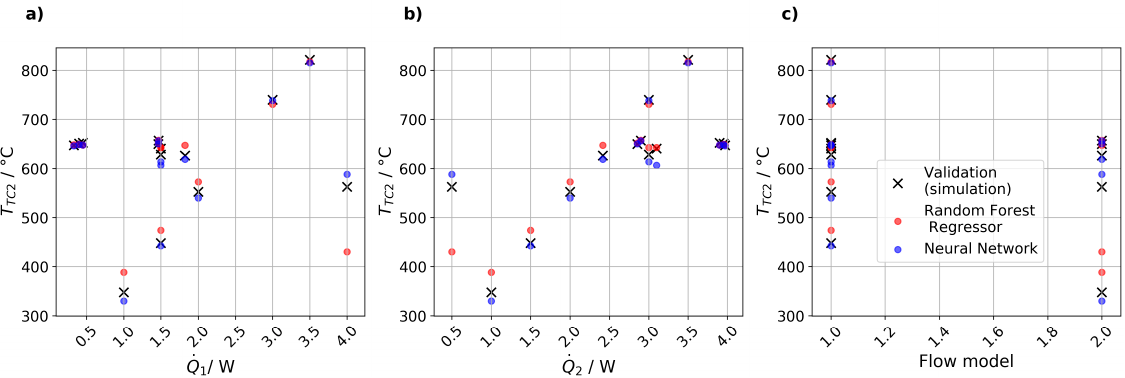
Figure 6. Exemplarily comparison of prediction data from random forest regressor and neural network to test data. ( a ) Bottom temperature T TC,2 as a function of top power 𝑄(cid:4662) 1 , ( b ) bottom tem- perature T TC,2 as a function of bottom power 𝑄(cid:4662) 2 , ( c ) splitting of the data by the third feature, namely flow model.